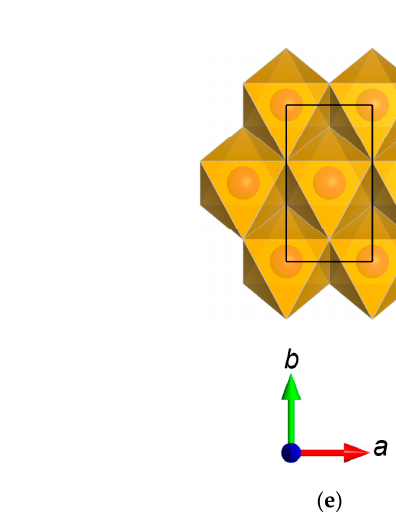
Figure 1. ( a ) X-ray diffraction (XRD) patterns of the prepared Na 0.50 (Co x Mn 1 − x )O 2 ( x = 0.157, 0.211 or content x ; ( c ) XRD pattern of prepared Na 0.50 MnO 2 ; ( d ) model of the crystal structure of Na 0.50 MnO 2 ; ( e ) top view of the oxide layer of ( d ). The black solid lines in ( d , e ) indicate the unit cell.